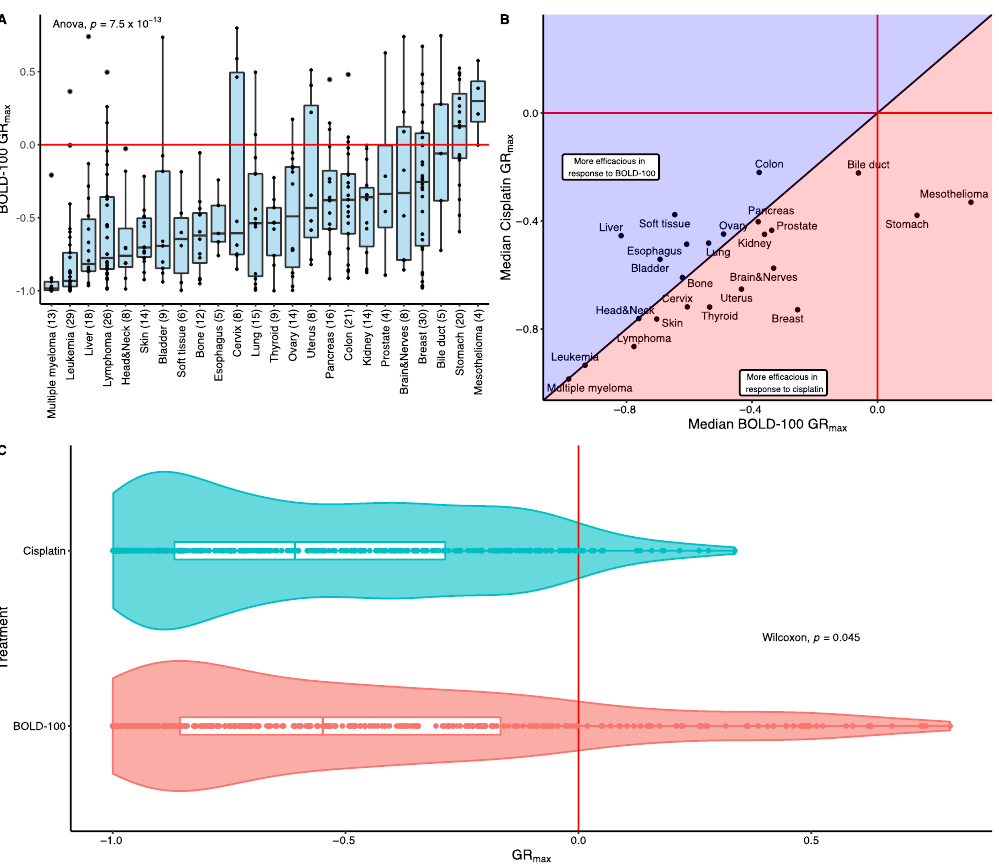
Figure 2. The cytotoxicity of BOLD-100 in the cancer cell line panel. ( A ) The GR max distribution of BOLD-100 grouped by tissue lineages. The red horizontal line represents the threshold for cytotoxicity (i.e., GR max = 0). The length of each box represents the range between the 25th and the 75th percentile whereas the whiskers represent the threshold for outlier values. The x-axis labels indicate the tissues of origin (number of cell lines). ( B ) The comparison of within-tissue median GR max in response to BOLD-100 or cisplatin treatment. The bisecting diagonal line represents the decision boundary for which treatment exerts a more cytotoxic response. ( C ) The comparison of overall GR max distribution across the entire cell panel in response to BOLD-100 or cisplatin. The vertical red line indicates the threshold for cytotoxicity (i.e., GR max = 0).